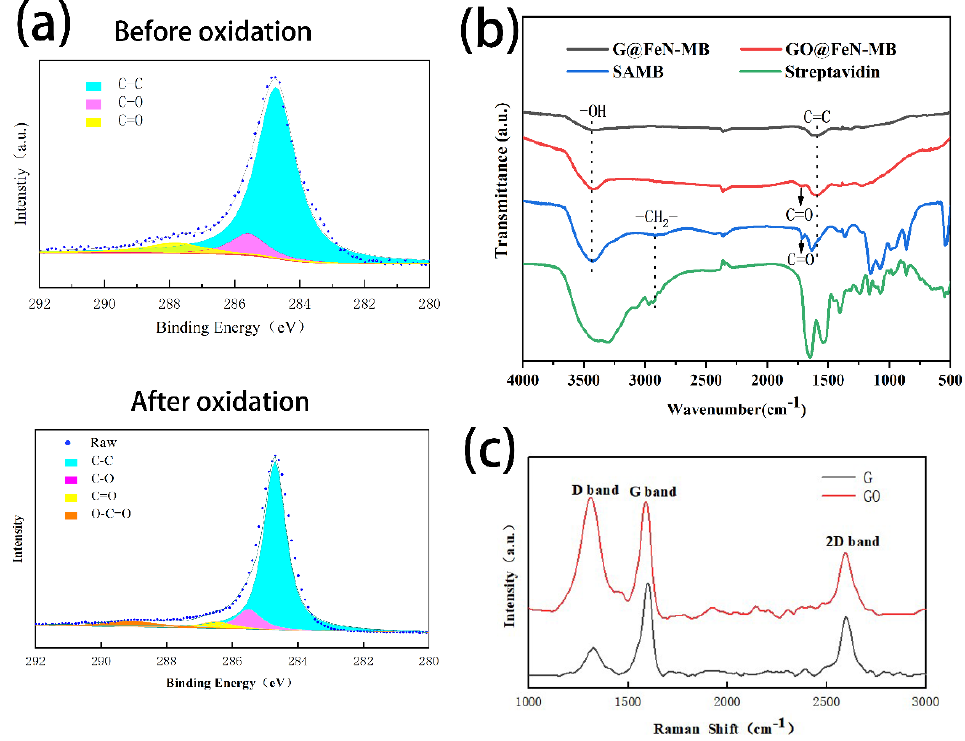
Figure 3. The oxidation effect of G@FeN-MB: ( a ) X-ray photoelectron spectroscopy analysis